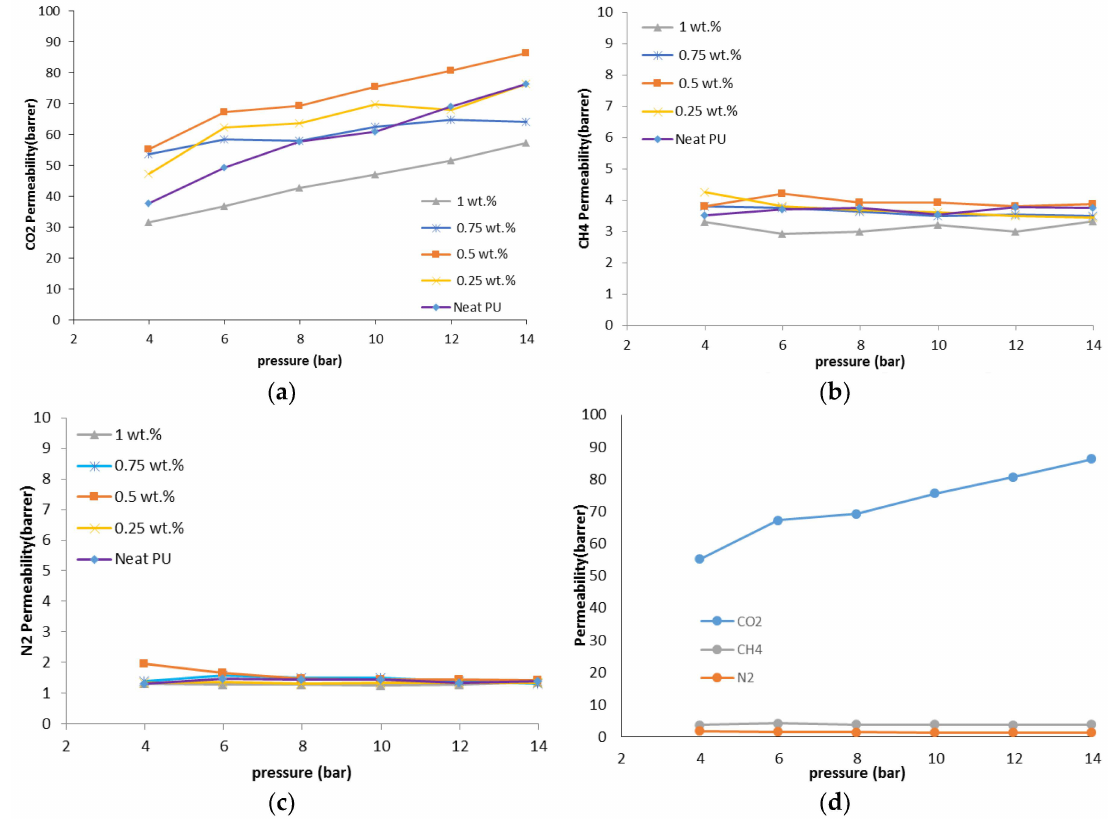
Figure 6. Effect of ZnO nanoparticle on the membrane permeability. Figure 7. Effect of ZnO nanoparticle on the membrane permeability.